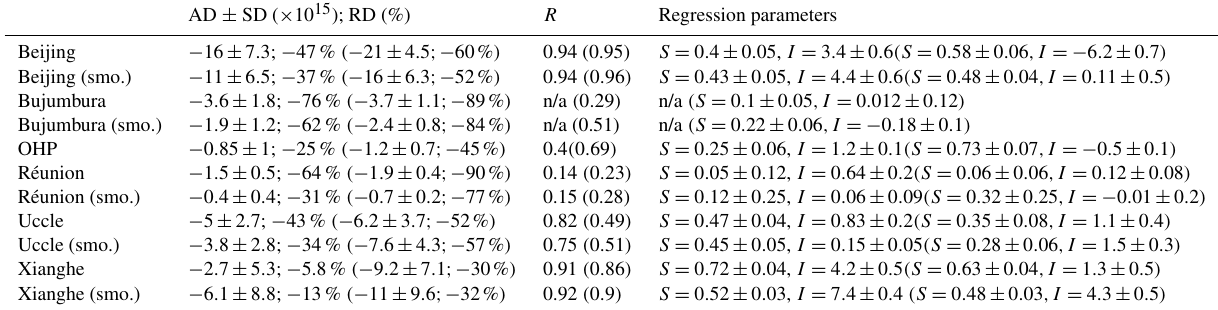
Table 4. Averaged absolute differences (AD, SAT-GB in 10 15 moleccm 2 ), relative differences (RD, (SAT-GB)/GB in %), standard deviation (SD), correlation coefficient R , and regression parameters (slope S and intercept I ) of the orthogonal regression for the monthly means GOME-2A tropospheric NO 2 product when comparing to MAXDOAS data. Values for GDP 4.9 (this study) are given and the values for GDP 4.8 are reported in brackets for comparison. Results for both the original comparisons and the smoothed comparisons (smo.) are reported.